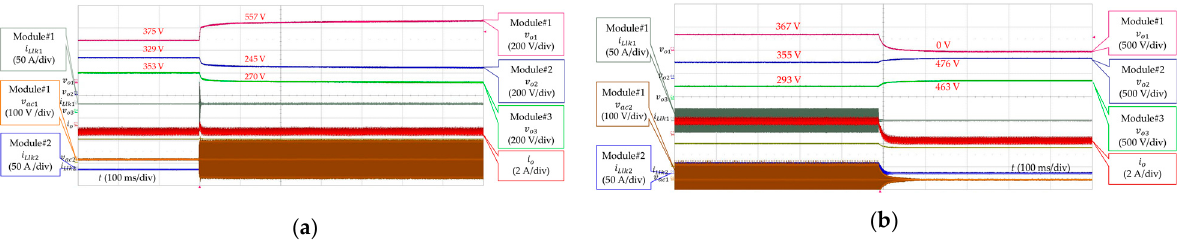
Figure 22. The startup and shutdown process of Module#1. ( a ) Startup process; ( b ) Shutdown process.